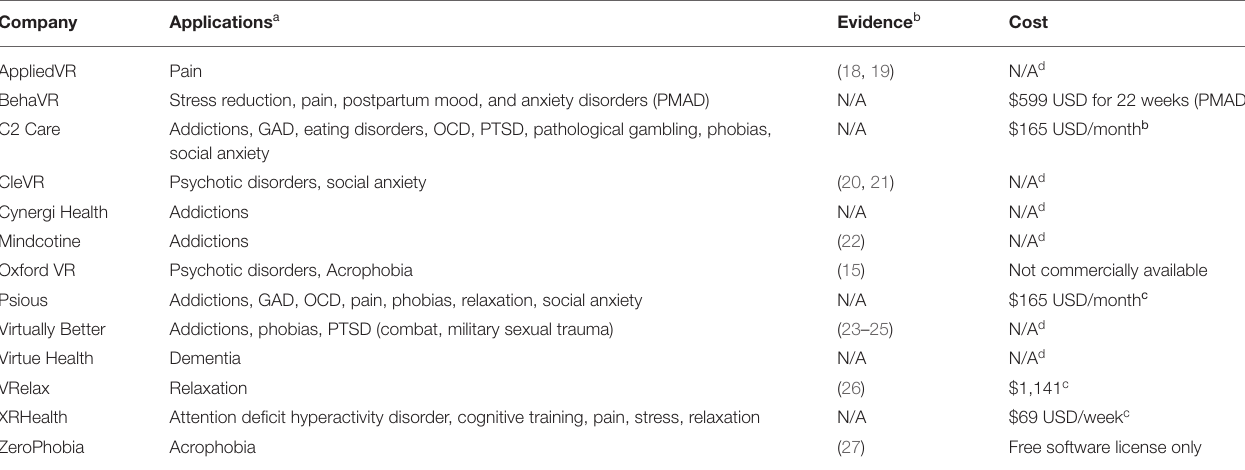
TABLE 2 | Therapeutic VR software vendors for mental